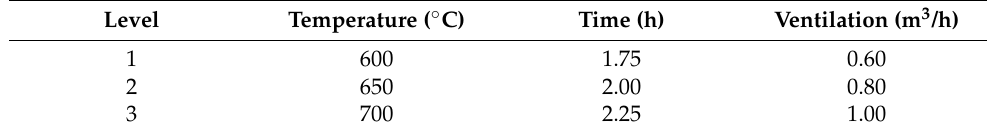
Table 4. Different levels of factor and the amount of orthogonal experiment for roasting.